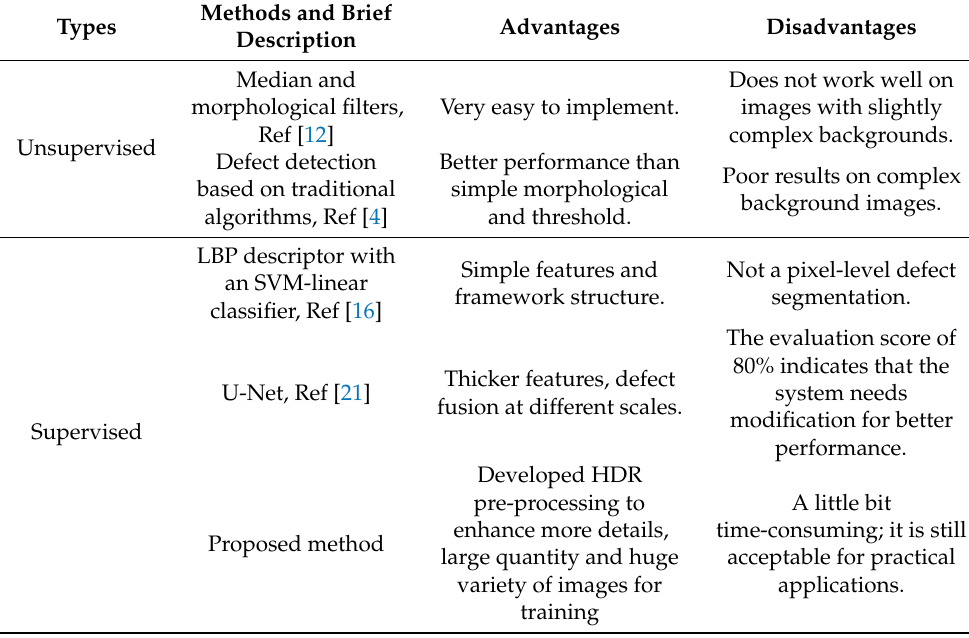
Table 1. The comparison between the proposed method and other industrial X-ray defect detec- tion